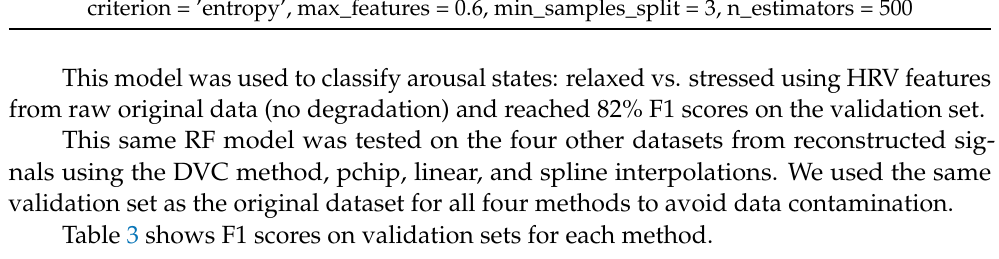
Table 3. F1 scores for each data imputation method.